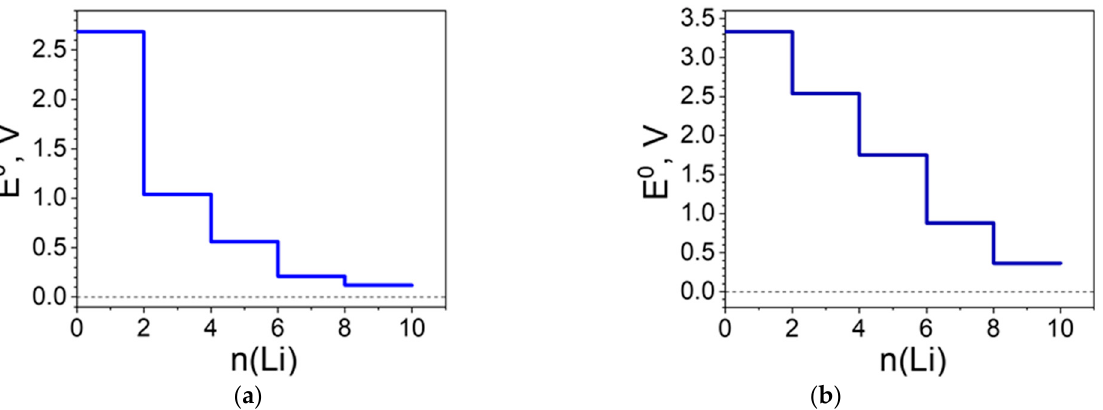
Figure 10. Redox potential profile (E 0 vs. Li + /Li 0 ) of: ( a ) [Ni(II)L2] n and ( b ) [Ni(IV)L2] n upon lithia- tion.